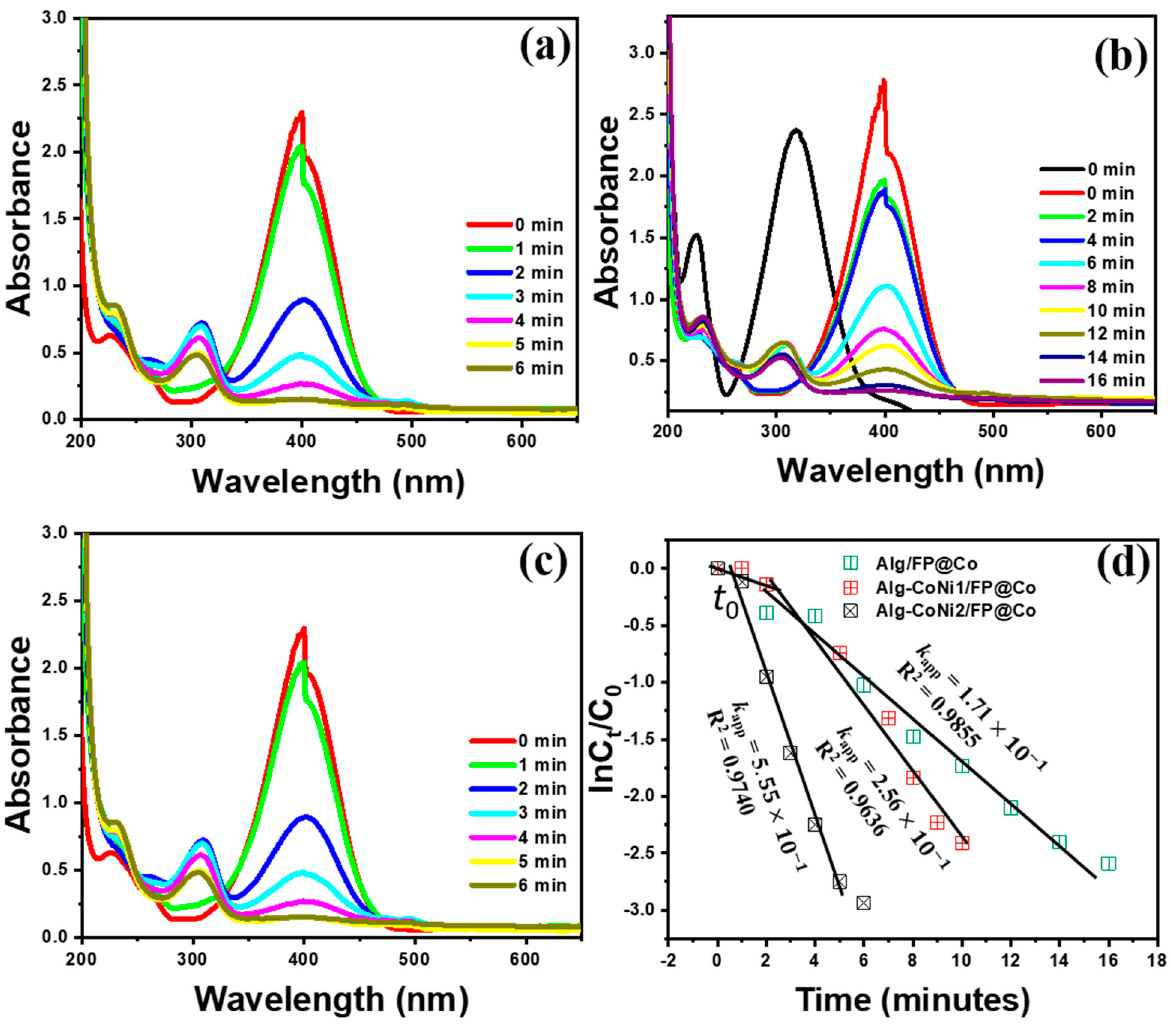
Figure 6. UV-Vis. absorbance spectra of 4NP reduction in the presence of NaBH 4 using Alg/FP@Co ( a ), Alg-CoNi1/FP@Co ( b ), and Alg-CoNi2/FP@Co NPs ( c ), and linear relationship of pseudo-1st order kinetics ( d ). Table 4. Comparative literature data for CR, MO, and 4NP degradation with the present data.